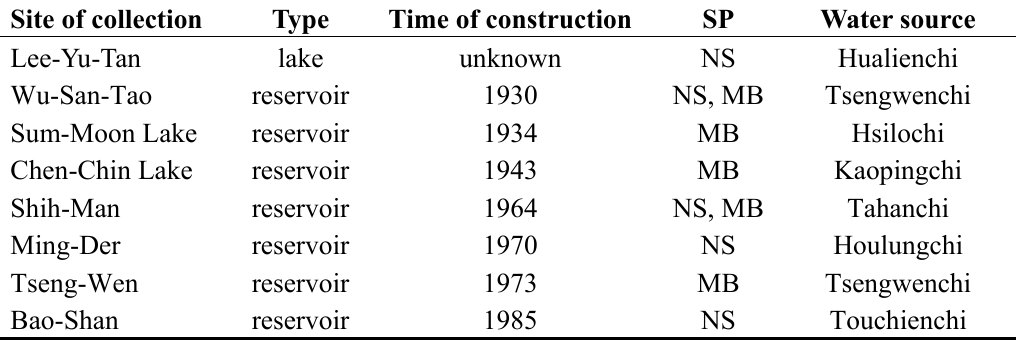
Table 7. Collection site for each population and construction time of each